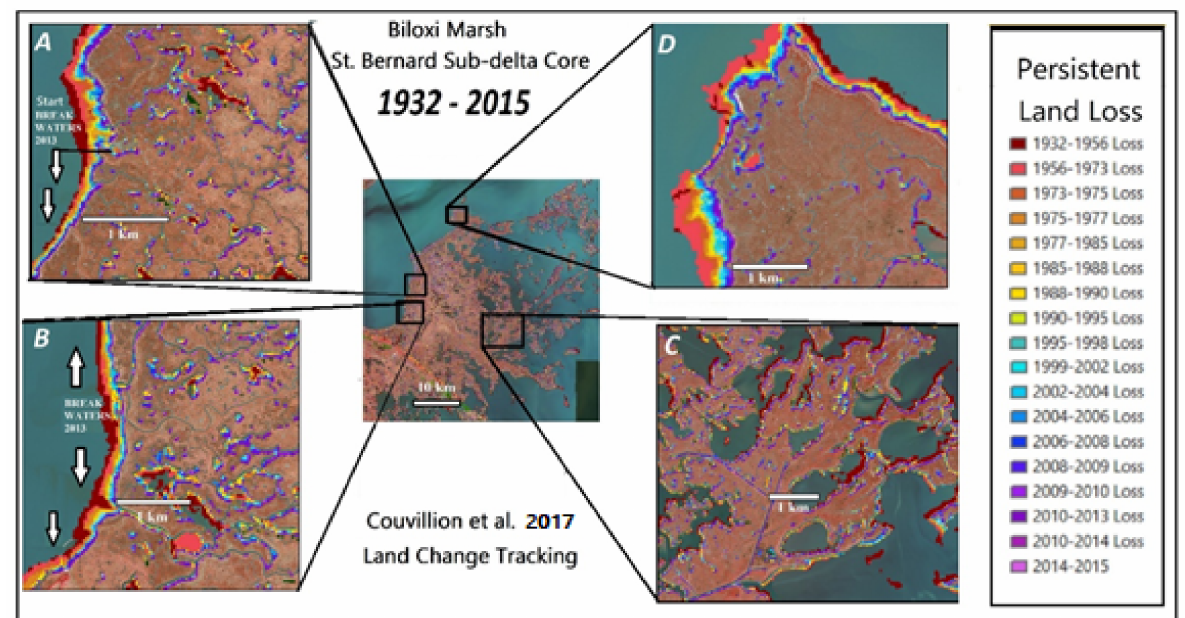
Figure 7. Biloxi Marsh historical land-loss adapted from Couvillion et al. [10]. Land-loss has varied over time and space. Loss that occurred in the 1950s through 1980s is depicted in brown, red and yellow, while more recent loss is shown in blues and violets. Shoreline retreat on the Lake Borgne coast has always been the principal cause of land-loss ( A , B , D ). New breakwaters in southern Lake Borgne are slowing or reversing shoreline retreat ( A , B ). More recently, cumulative interior marsh loss has increased as abandoned tidal channels have enlarged into lakes ( A , B ). Most interior land-loss occurred earlier in the southeast ( C ) to form stable rounded lakes. Shoreline retreat is most rapid at the northern tip of Biloxi Marsh but interior marsh loss is lower than elsewhere on the peninsula ( D